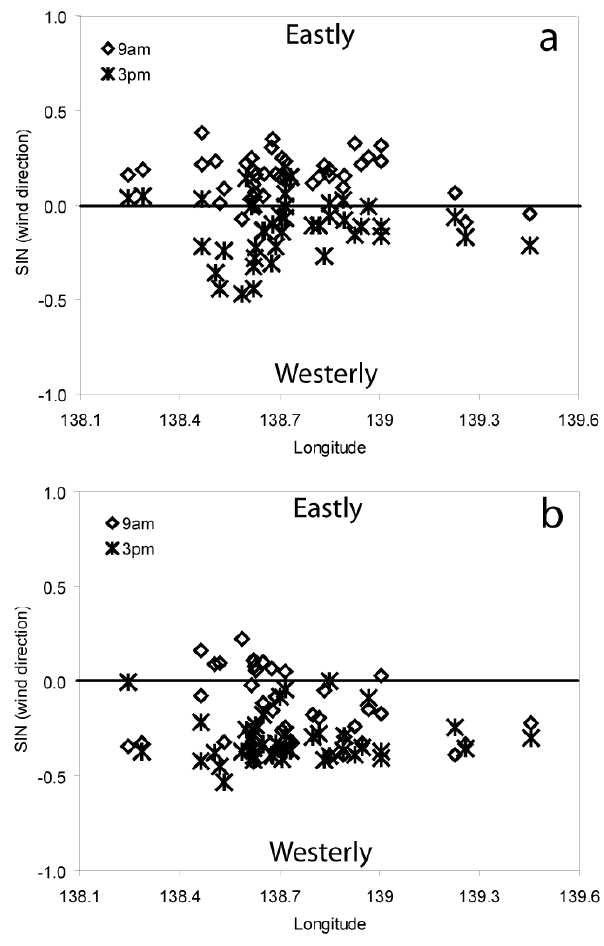
Fig. 7. Mean values of sin(wind direction) at the 41 observation sites (Fig. 1) for two seasons: (a) summer months (12, 1, 2), and (b) winter months (6, 7,